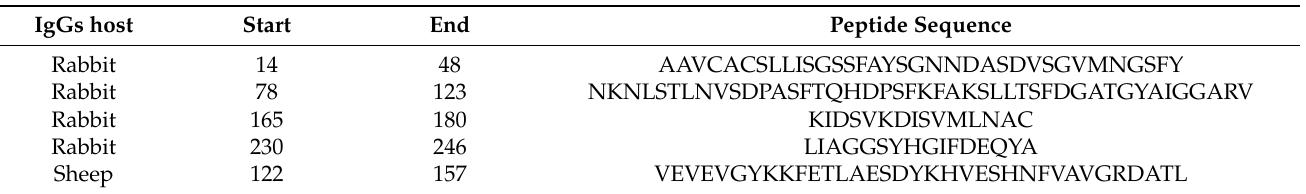
Table 1. A. phagocytophilum MSP4 (GenBank ID: AFD54597) predicted immunogenic peptides reactive to IgGs from rabbit and sheep immunized with the recombinant